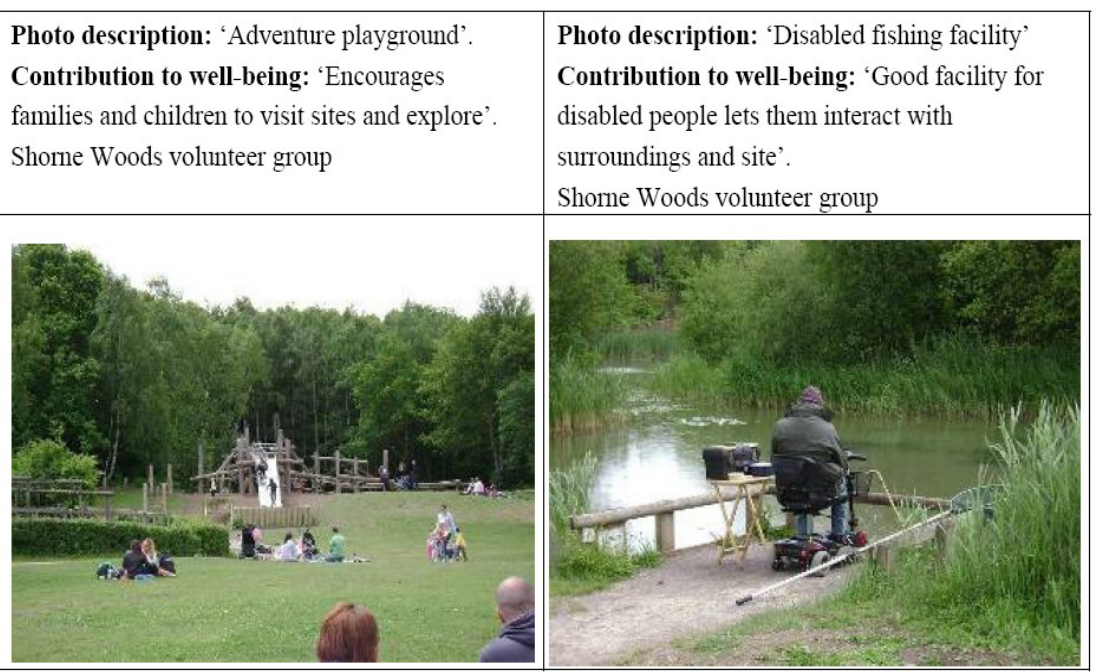
Figure 1. Infrastructure and facilities can attract and assist